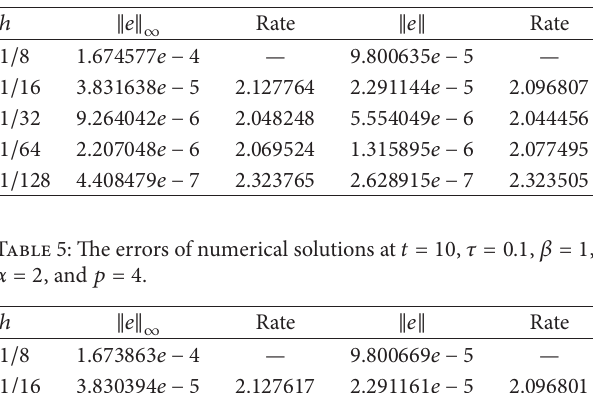
Table 4: The errors of numerical solutions at 𝑡 = 10 , 𝜏 = 0.1 , 𝛽 = 1 , 𝛼 = 2 , and 𝑝 = 2 .